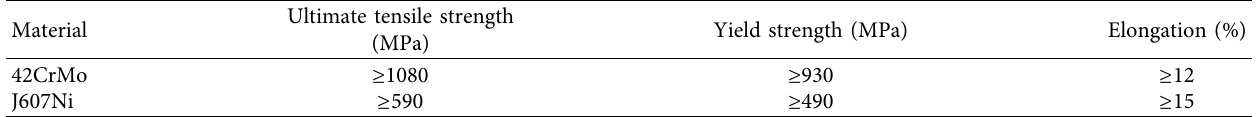
Table 2: Mechanical properties of 42CrMo(4140) and J607Ni(E9015-G). Ultimate tensile Material